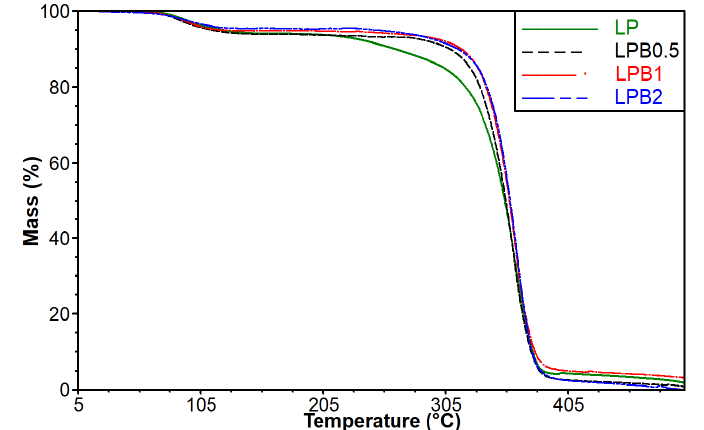
Figure 4. TG curves for polylactide-based materials both comprising and lacking berberine.